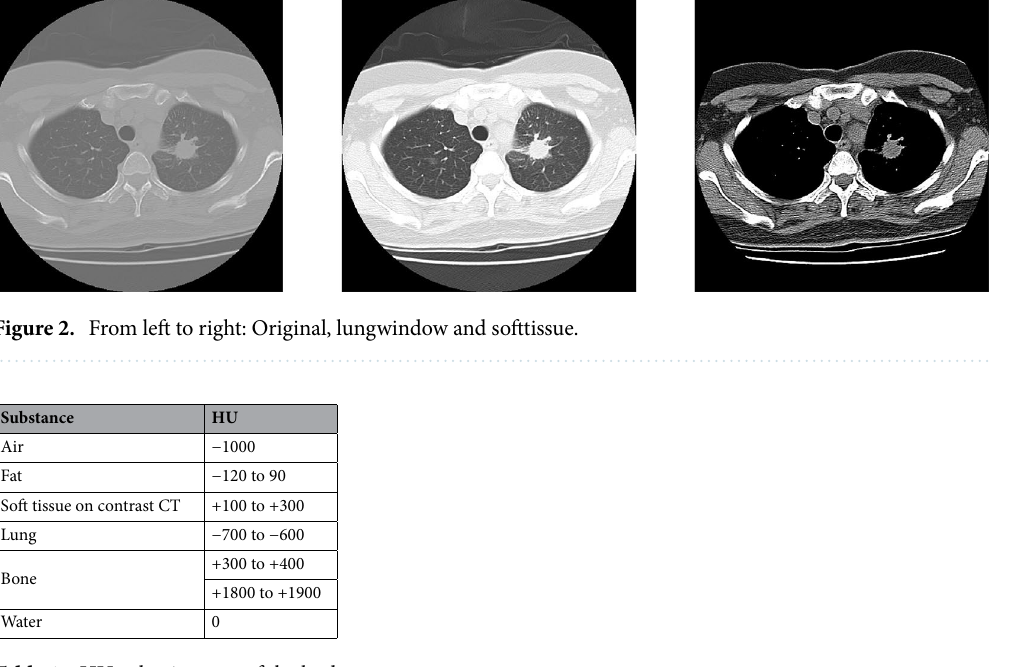
Table 1. HU value in parts of the